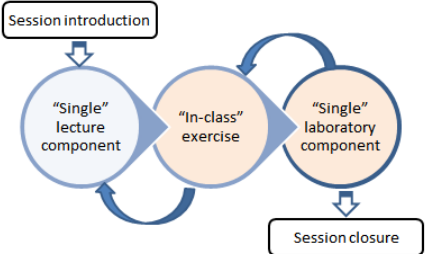
Figure 3. Third design model for face-to-face teaching sessions for computing courses extensively using enterprise level systems in their